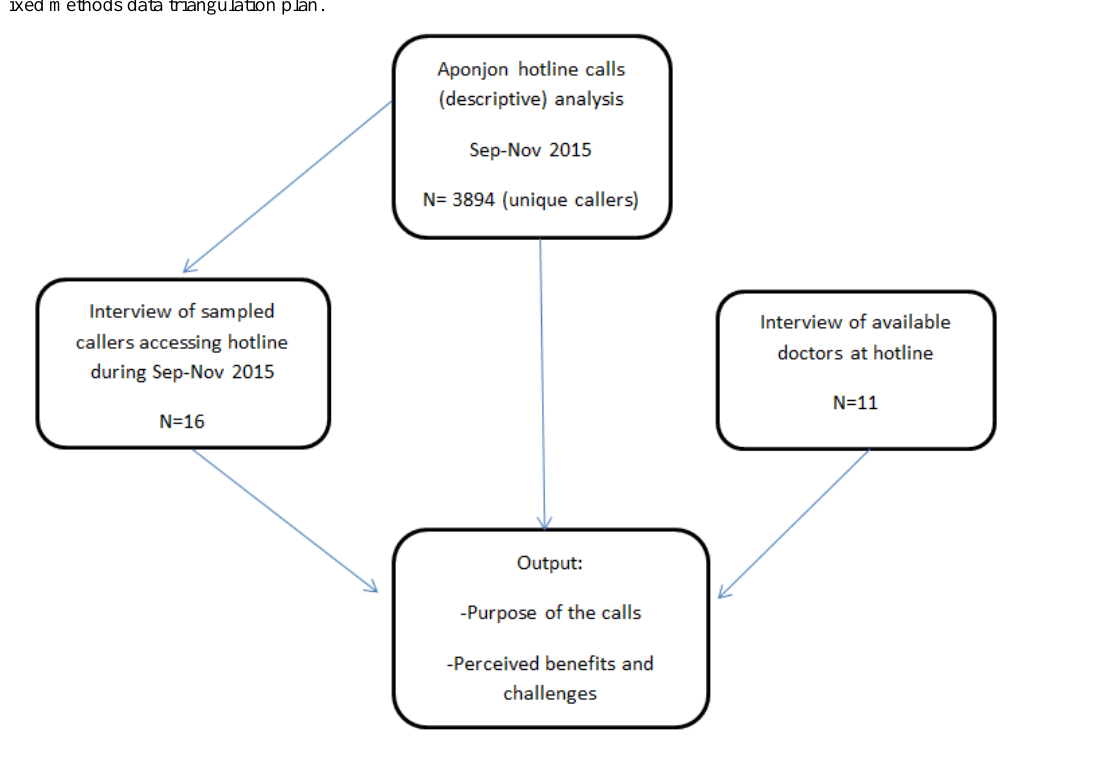
Figure 1. Mixed methods data triangulation